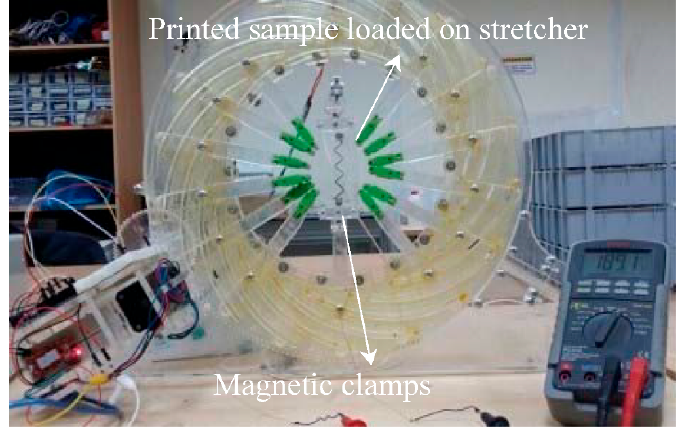
Figure 1. Stretching tool used to apply axial strain while measuring the electrical resistance of the printed lines.